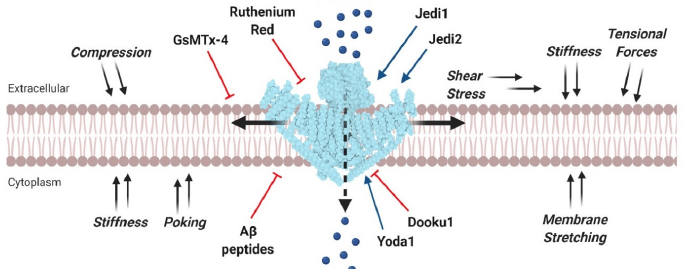
Figure 1. Mechanical and pharmacological modulation of Piezo1 channels. Mechanosensitive Piezo1 channels expressed on the plasma membrane are gated by various mechanical stimuli (black arrows). Channel activation allows a Ca 2+ influx (blue spheres) into the cytoplasm which mediates countless cell responses. Piezo1 may be pharmacologically activated by agonists (blue arrows) or inhibited by channel pore blockers, competitive antagonists, and peptides, which distort the membrane mechanical properties (red inhibitory arrows). Structural data for Piezo1 channel were taken from Protein Data Bank (accession code: 3JAC) and created with BioRender.com.